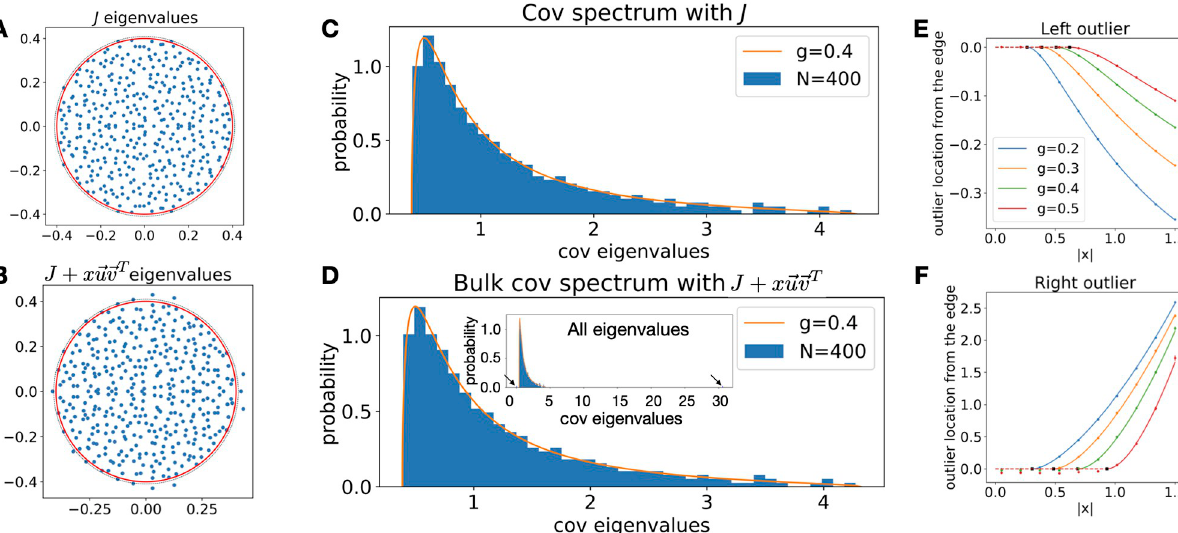
Fig 5. Robustness of the covariance spectrum to low rank perturbations of the connectivity. A . Eigenvalues of a Gaussian random connectivity J (Eq (3)), g = 0.4, N = 400. As N ! 1 , the limiting distribution of eigenvalues is uniform in the circle with radius g ([34] red solid line). The black dashed line is the 0.995 quantile of the eigenvalue radius calculated from 1000 realizations. B . Same as A. but for the rank-1 perturbed J + xuv T . ffiffiffiffi p , v � i : i : d : N ð 0 ; 1 = N Þ and x = 4.03. This example also corresponds to adding diverging motifs (Section 3.3 and Section C.1 in u ¼ ð 1 ; 1 ; ... ; 1 Þ T = N i S1 Text). C . The histogram of covariance eigenvalues (Eq (2)) under the J in A. D . The bulk histogram of eigenvalues with J + xuv T has little change and remains well described by the Gaussian connectivity theory (red line, Eq (5)). Besides the bulk, there are two outlier eigenvalues to the left and right (inset, arrows) E,F , Analytical predictions (solid and dashed lines) of the outlier locations given g and | x | when u , v are (asymptotically) orthogonal unit vectors that are independent of J (see other cases in Section C.3 in S1 Text). The y-axis is the outlier location subtracting the corresponding edge x (6), so it is zero for small | x | before the outlier emerges (dashed line). The dots are the mean of the smallest (for the left outlier) or largest (right outlier) eigenvalues averaged across 100 realizations of the random J , N = 4000. The errorbars are the standard error of the mean (SEM, many are smaller than the dots).